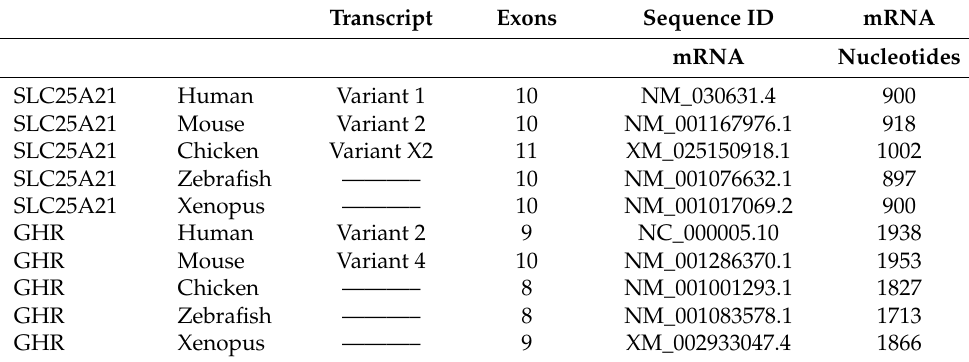
Table 1. The transcripts and their mRNAs (NCBI GenBank).